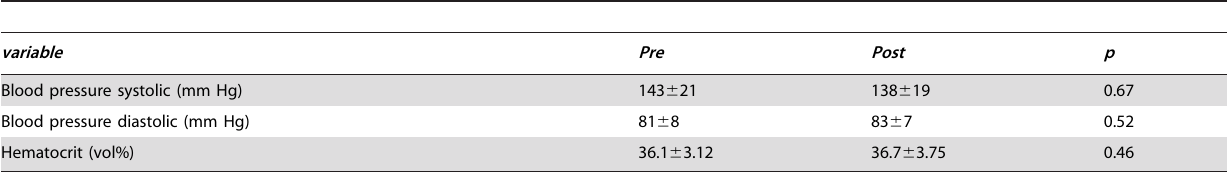
Table 2. Blood pressure systolic, Blood pressure diastolic and Hematocrit of the ESRD patients at the start and end of hemodialysis treatment